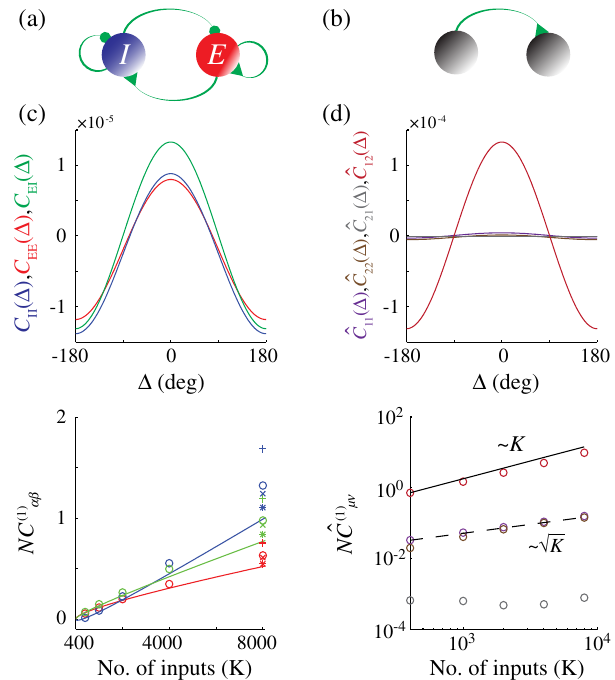
FIG. 5. Correlations in a two-population network with a hidden feed-forward structure. (a) Network architecture. All connections are modulated. Connection probabilities are as in Eq. (29) with 1 Þ 1 Þ 1 Þ 1 Þ f ð ¼ 0 . 373 , f ð ¼ 0 . 0224 , f ð ¼ 0 . 0487 , f ð ¼ 0 . 1623 . Con- EE EI II IE nection strengths are as in Figs. 2 and 3. (b) Hidden feed-forward structure of the mode n ¼ 1 as revealed in the Jordan basis. (c) Top panel: Simulation results for C αβ ð Δ Þ . N ¼ 40 000 , 1 Þ K ¼ 2000 . Bottom panel: NC ð αβ vs K . Solid lines: Analytical results [Eq. (27)]. Simulations are plotted for N ¼ 20 000 (plus), N ¼ 40 000 (circles), N ¼ 80 000 (cross), and N ¼ 160 000 (asterisks). (d) Top panel: Correlation matrix in the Jordan basis ¯ J ð 1 Þ ˆ ˆ ˆ C 11 ð Δ Þ ; brown, C 22 ð Δ Þ ; gray, C 21 ð Δ Þ ; red, of . Purple, ˆ ˆ 1 Þ C 12 ð Δ Þ . Bottom panel: N C ð μν vs K in log-log scale. Solid line: Linear fit. Dashed line: Fit to a square root function.